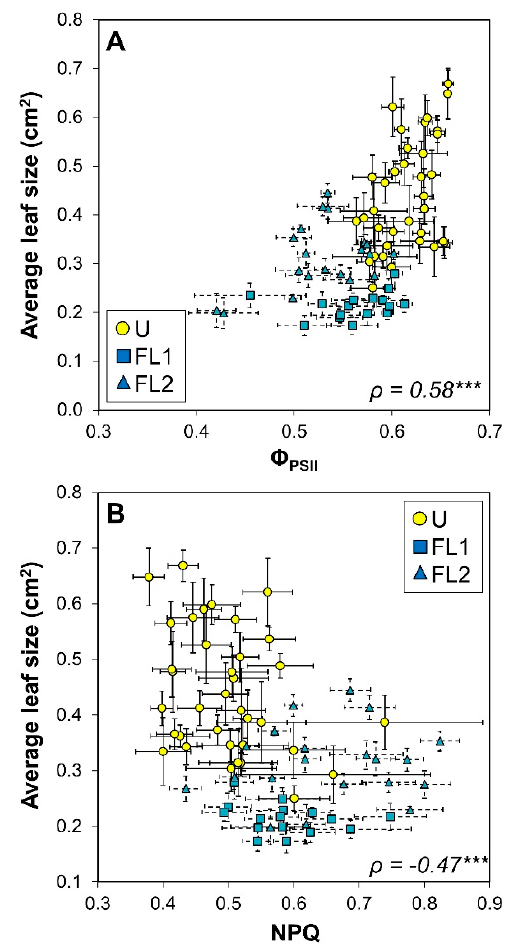
Figure 5. Relationships between average leaf size and ( A ) photosystem II operating efficiency ( Φ PSII ) and ( B ) non-photochemical quenching (NPQ) in 36 Arabidopsis accessions acclimated to uniform (U) and fluctuating light intensities (FL). Data from plants grown under FL are sorted by experiment 1 (squares) and experiment 2 (triangles). Averages ± SE (n = 5–7). Spearman’s ρ and the significance of a linear correlation through all points is shown (*** = p <